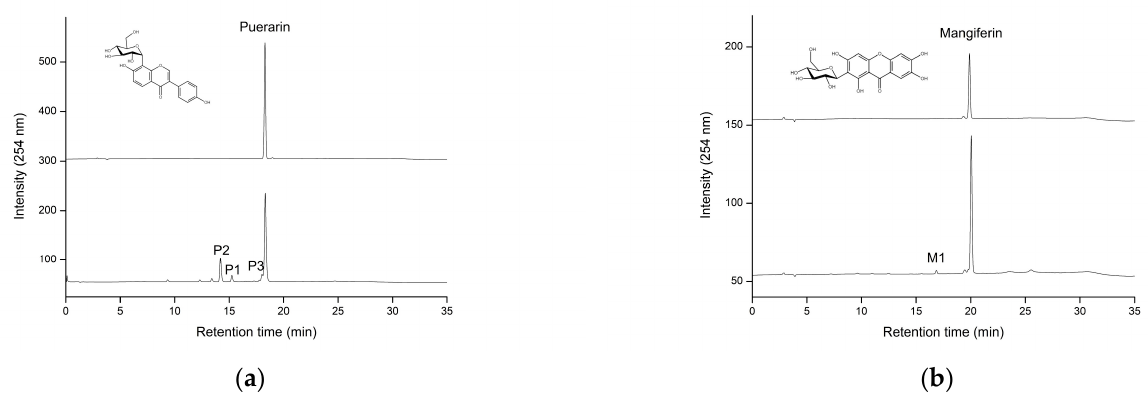
Figure 5. High-performance liquid chromatography (HPLC) analysis of the biotransformation products of puerarin ( a ) and mangiferin ( b ) by Pg MA. The reaction was performed with 1% ( w / v ) β -CD, 5.6 μ g/mL of Pg MA, and 1 mg/mL of puerarin or mangiferin at 50 mM of PB (pH 7) and 65 °C for 24 h. After the reaction, the reaction mixture was analyzed with HPLC. The conditions for HPLC are described in Section 2.